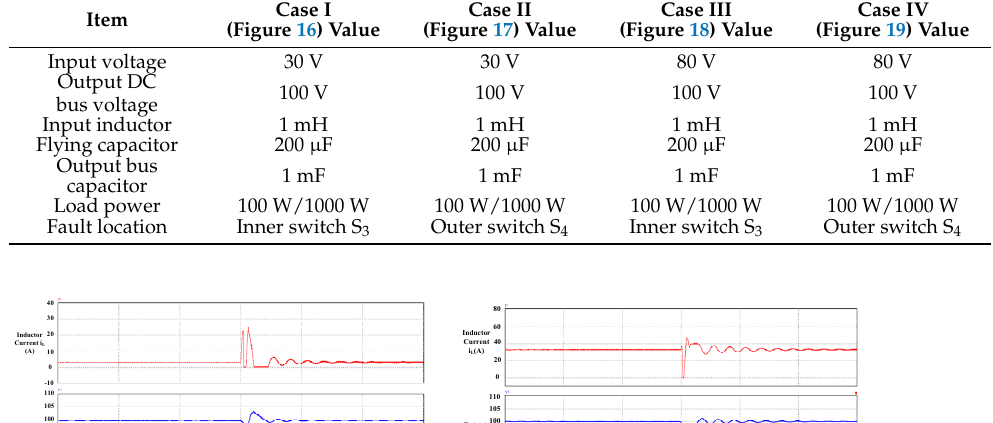
Figure 17. The waveforms of S 3 short-circuit fault (V L < 0.5 V H ). ( a ) Light load 100 W; ( b ) heavy load 1000 W. 20 10 0 100 99.5 0.2 ( b ) Figure 18. The waveforms of S 3 short-circuit fault (V L > 0.5 V H ). ( a ) Light load 100 W; ( b ) heavy load 1000 W.